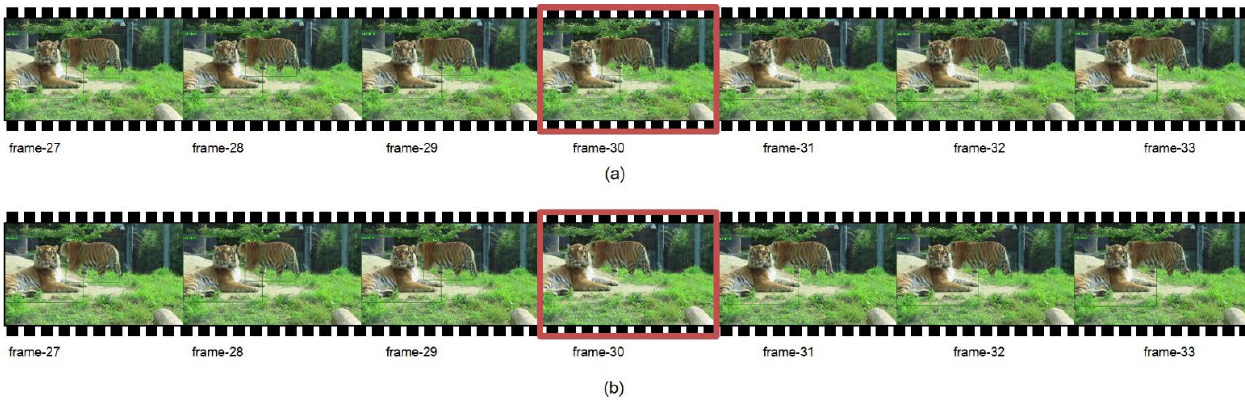
Figure 10. Tracking sequence before and after frame 30: ( a ) performance without trajectory- reconstruction module; ( b ) performance with the trajectory-reconstruction